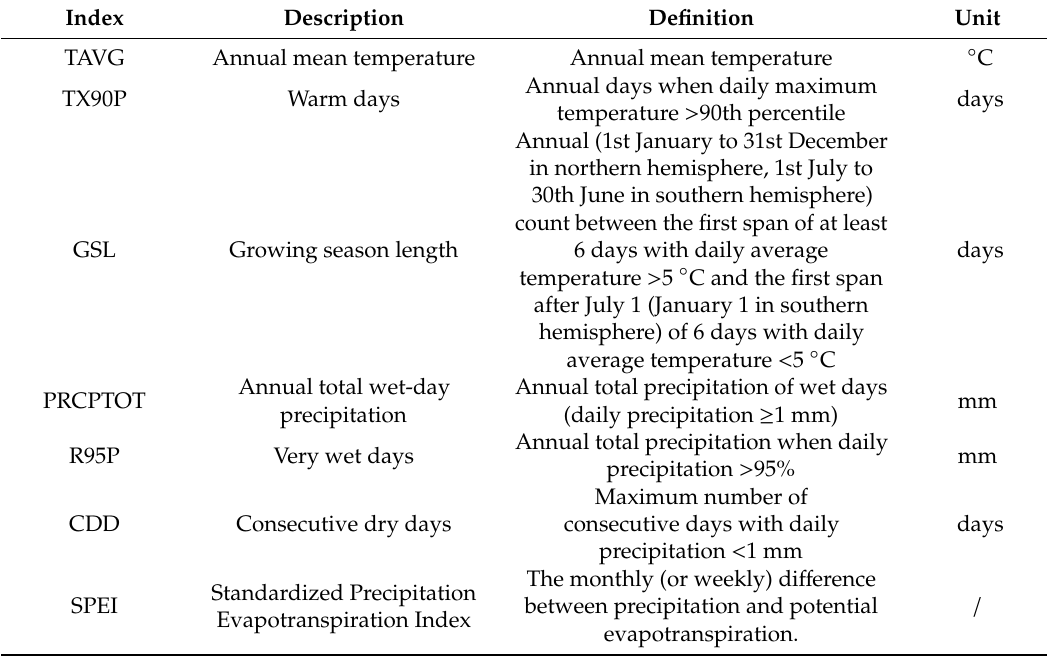
Table 2. Definitions of the selected climate